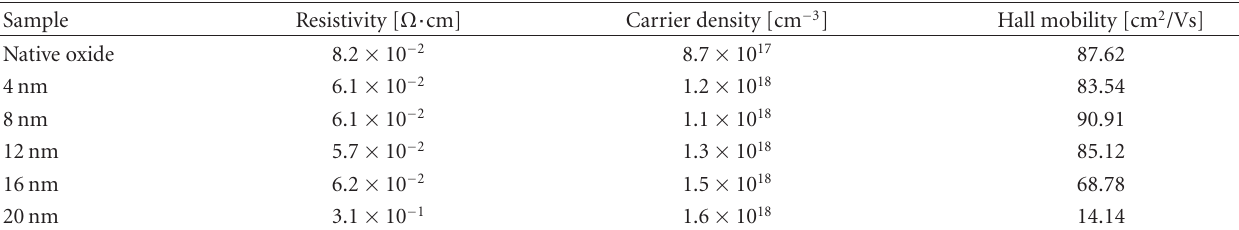
Table 2: Electrical properties of pc-Si films produced by AIC process for various Al oxide layer